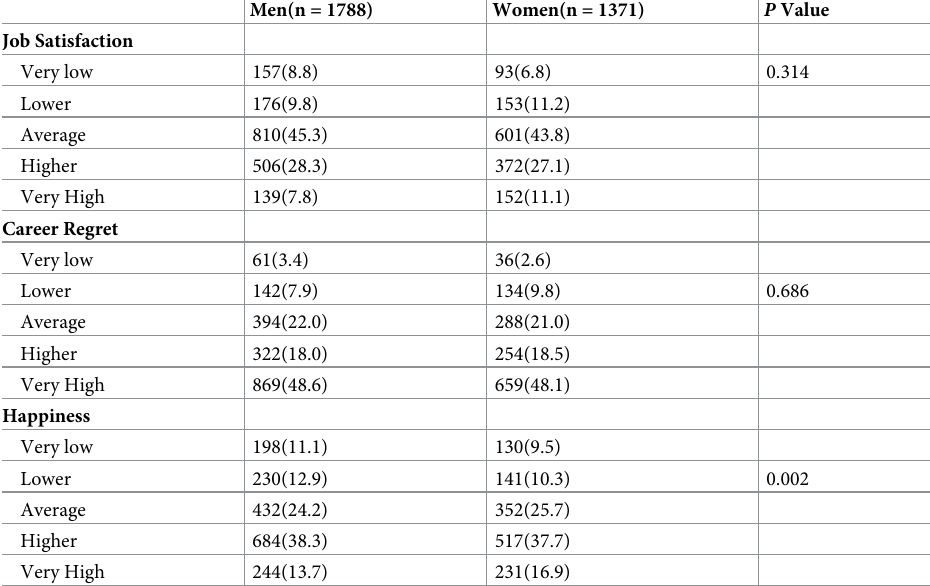
Table 3. Job satisfaction, career regret and happiness of physicians by